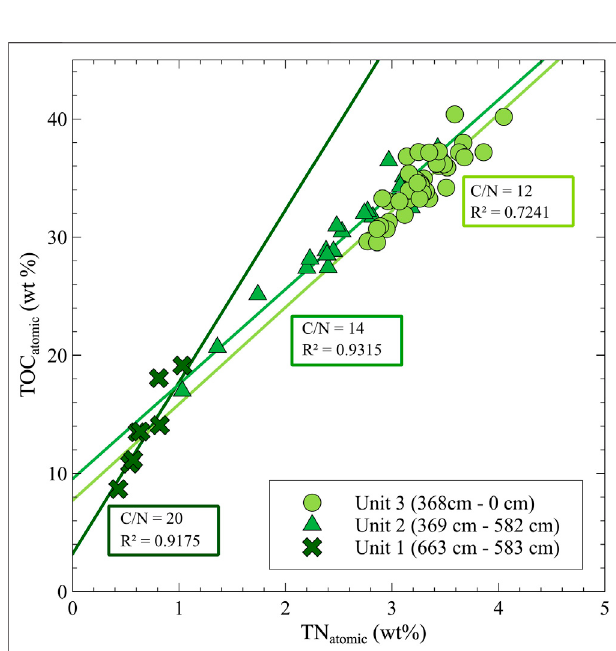
FIGURE 6 | Carbon (wt%) versus nitrogen (wt%) ratio by unit.